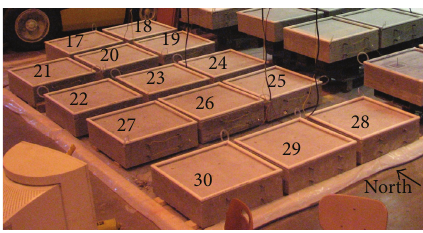
Table 1: Level of chlorides mixed into the CoC specimens (1 inch